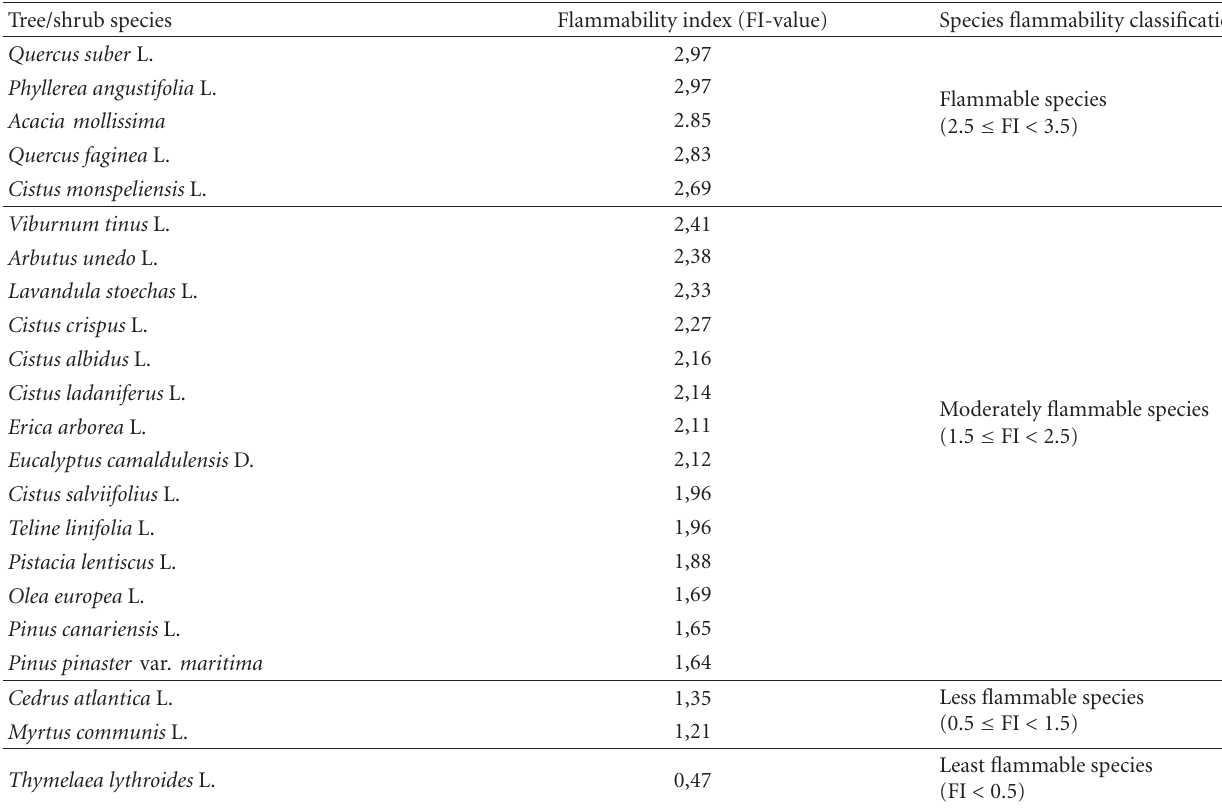
Table 6: Moroccan species classification using their flammability index (FI) values calculated from their linear equations (FI = a + b H) and their average moisture content of their leaves or needles determined during the critical summer period from July to September.